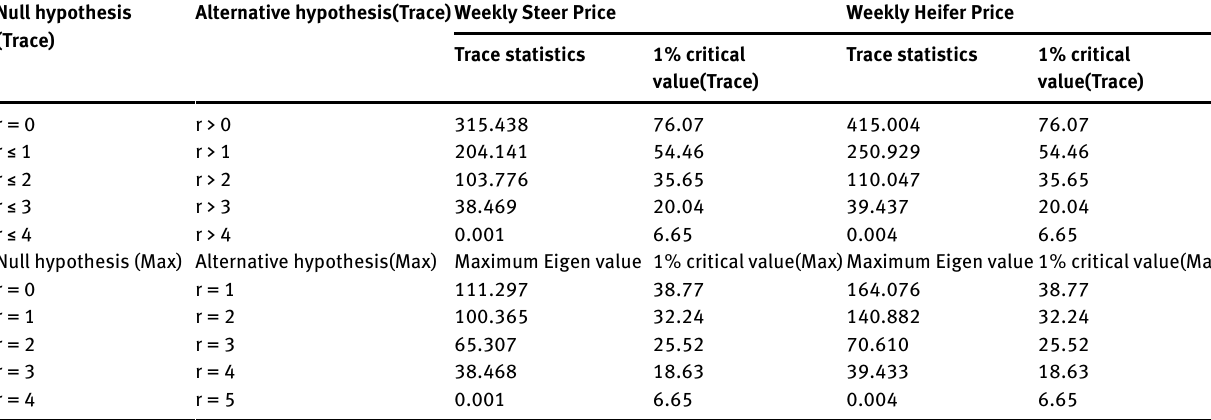
Table 4: Johansen Cointegration Test Results for Live Steer and Heifer Price Series Null hypothesis Alternative hypothesis(Trace)Weekly Steer Price (Trace)